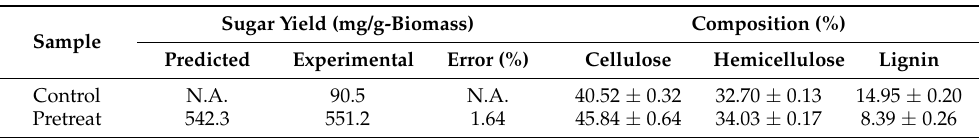
Table 3. Validation of predicted RSM model by measurement of sugar yields and effect of pretreat- ment on lignocellulose